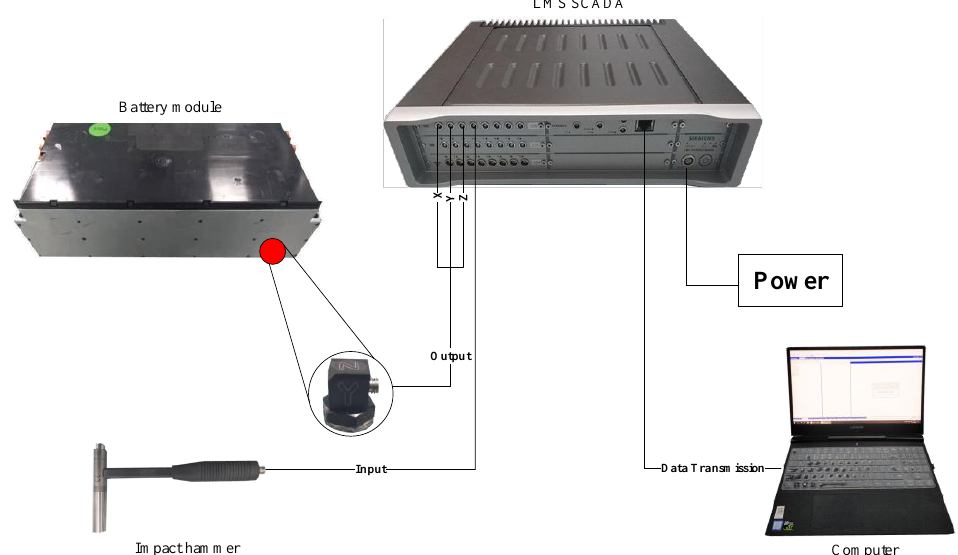
Figure 1. The connection of the battery module impulse excitation experiment. Table 1. Module